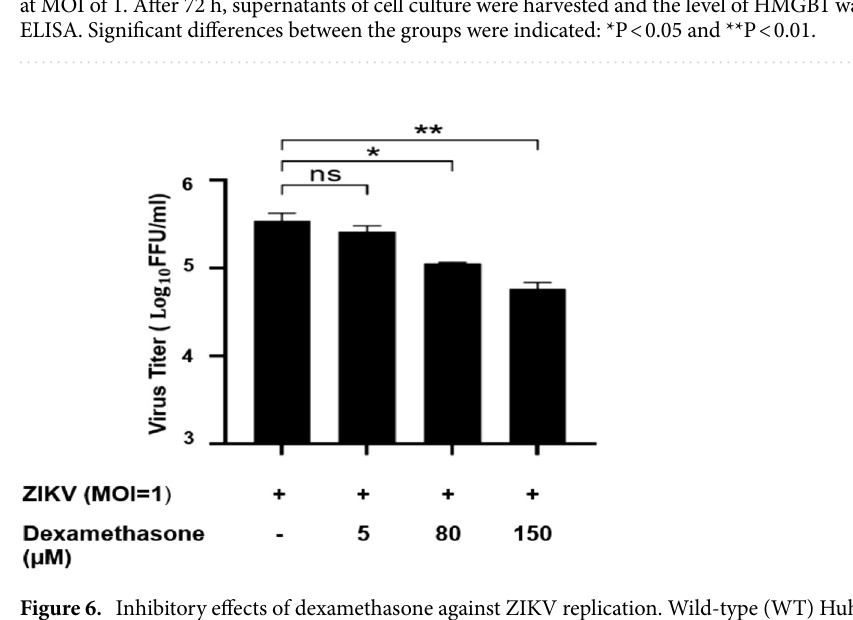
was observed in the early time point of infection (24 h.p.i.) prior to the onset of ZIKV CPE (Fig. 2), suggesting that HMGB1 release might not be a sole secondary effect of ZIKV-induced CPE. In contrast, a prior study found